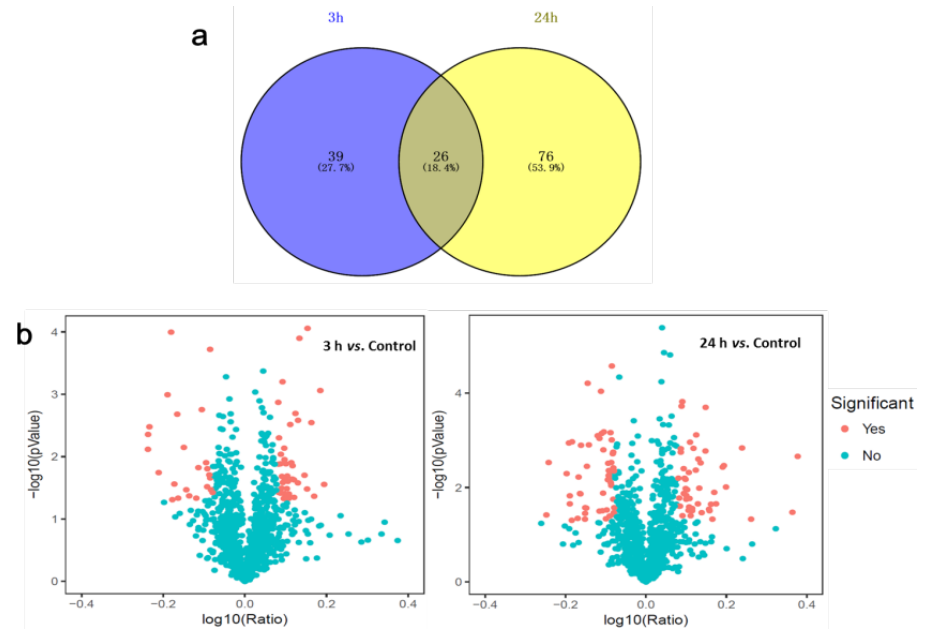
Figure 1. Differentially abundant proteins (DAPs) in response to salt stress in Dunaliella salina . ( a ) Venn diagram of 3 and 24 h specific DAPs with overlapping regions indicating the number of common proteins. ( b ) Volcano plots of the proteins quantified during iTRAQ analysis comparing control to 3 and 24 h salt treatments. Each point represents the difference in expression (fold-change) between the two groups plotted against the level of statistical significance. Proteins represented by a filled red square are those with expression that differs at a statistically significant level.